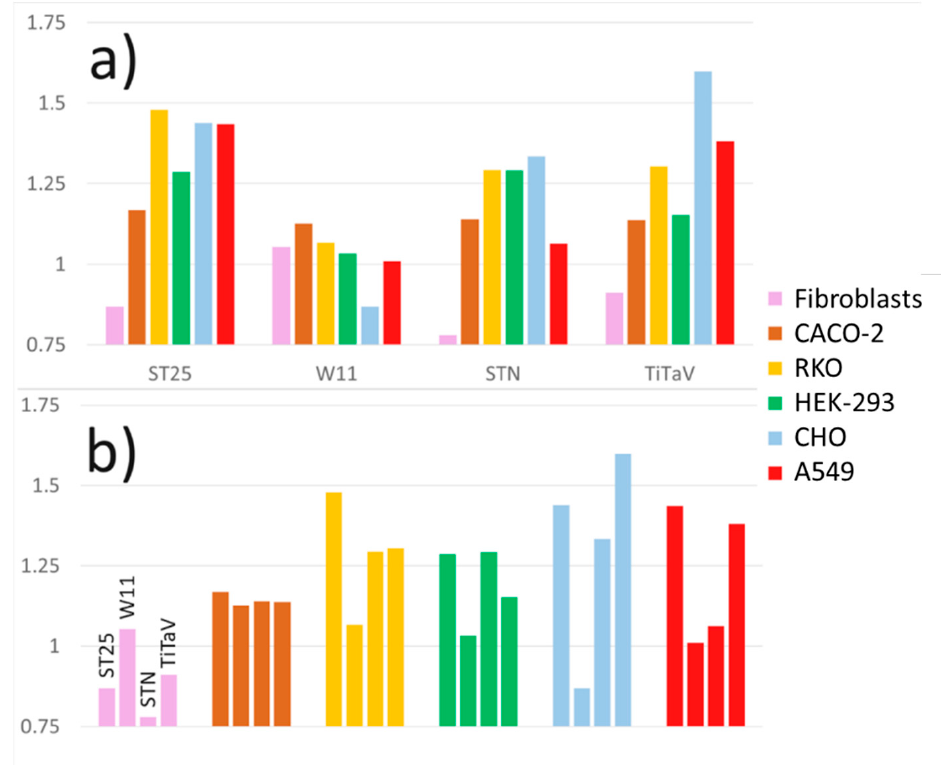
Figure 14. Sensor responses to different cell lines at same plating concentration and withdrawal time from the incubator. ( a ) Responses of the same sensor to different cell types; ( b ) responses of different sensors to the same cell type.